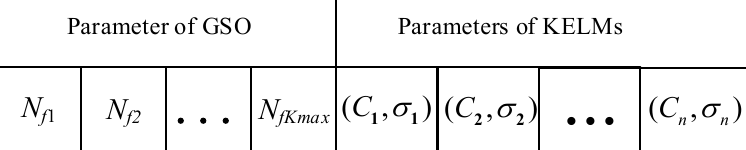
Figure 2. Encoding strategy in the location vector in the multi ‐ objective salp swarm algorithm (MOSSA).